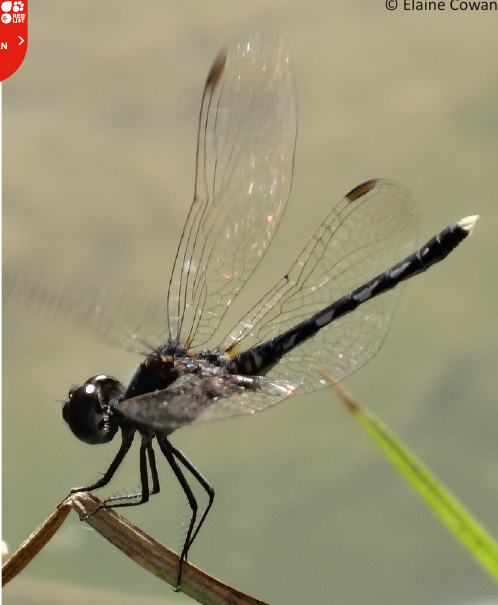
Image 19. Female Crocothemis erythraea , 31 March 2014. Brownish- yellow with pale antehumeral stripes, white dorsal stripe on thorax and dark lines on abdomen. Pale eyes, amber patch at wing bases and long pale pterostigmas. Vulvar scale at about right angles to the abdomen.